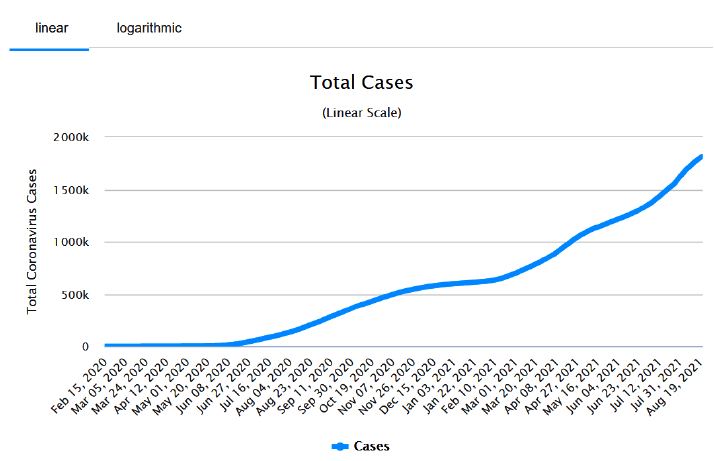
1. The total confirmed cases of COVID-19 in Iraq (Worldometer,